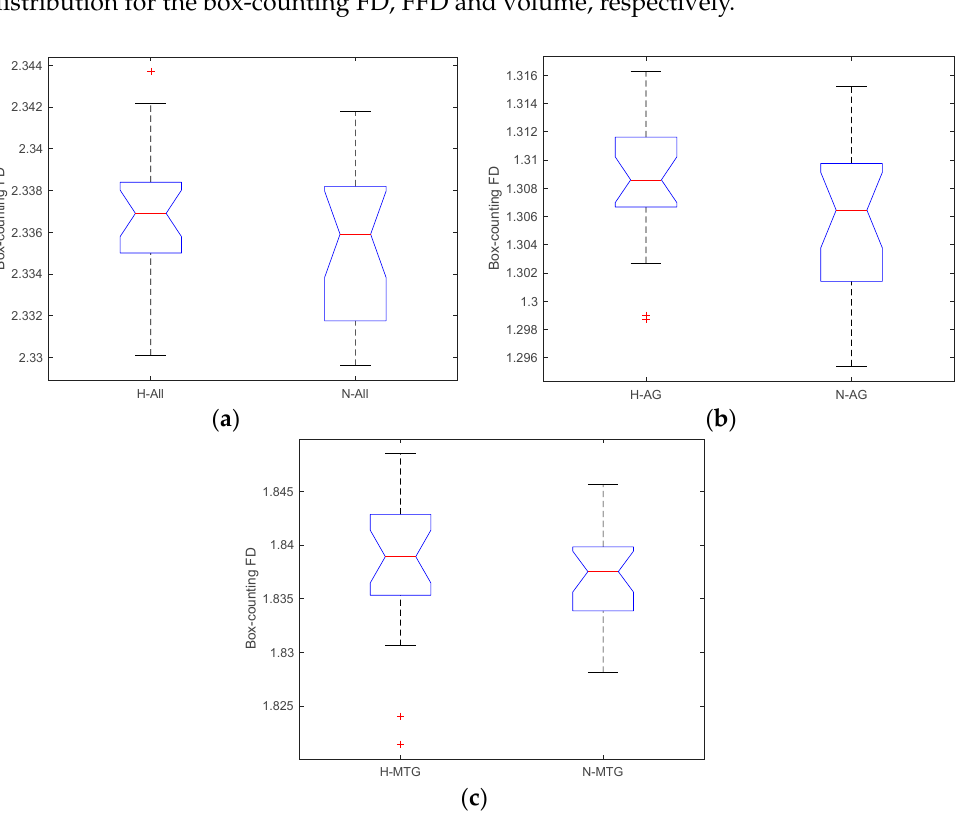
Figure 5. Box-counting FD values for huffaz and non-huffaz measured in the following VOI: ( a ) whole brain structure, ( b ) angular gyrus, and ( c ) middle temporal gyrus. The plus signs (+) indicate